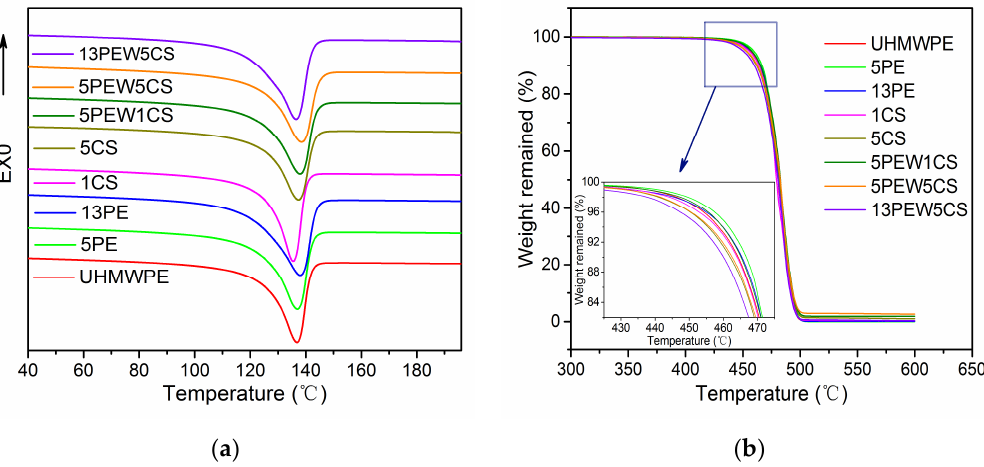
Figure 3. Thermal properties of UHMWPE with di ff erent contents of PEW and CS: ( a ) DSC curves; ( b ) TGA curves. Table 2. Characteristic points of the di ff erential scanning calorimeter (DSC) and TGA for UHMWPE with di ff erent contents of PEW and